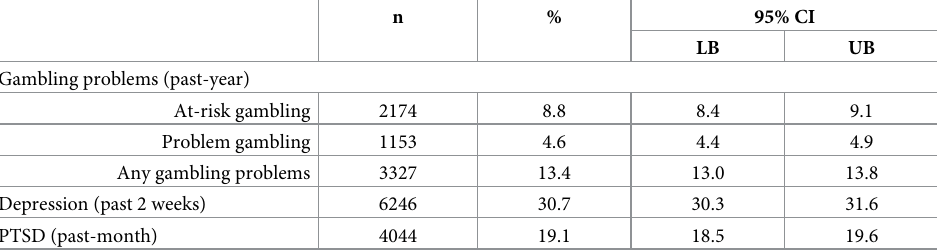
Table 1. Weighted gambling problems, depression, and PTSD rates (n =